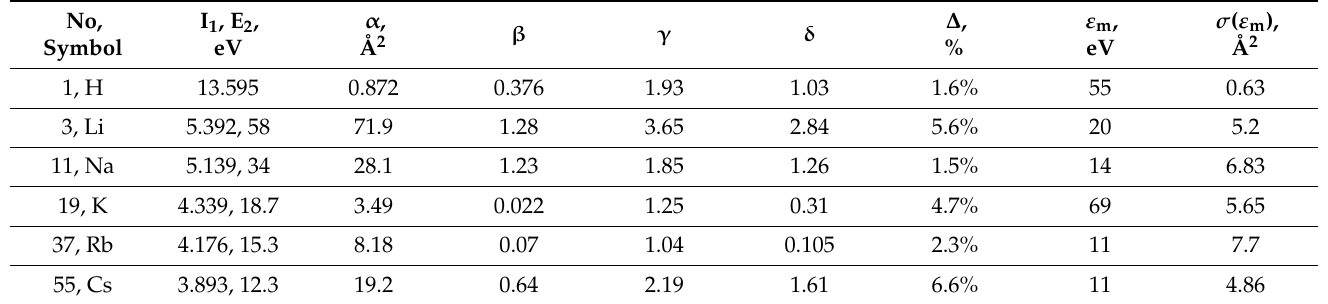
Table 4. Parameter values for approximating the ionization cross sections of H and alkali